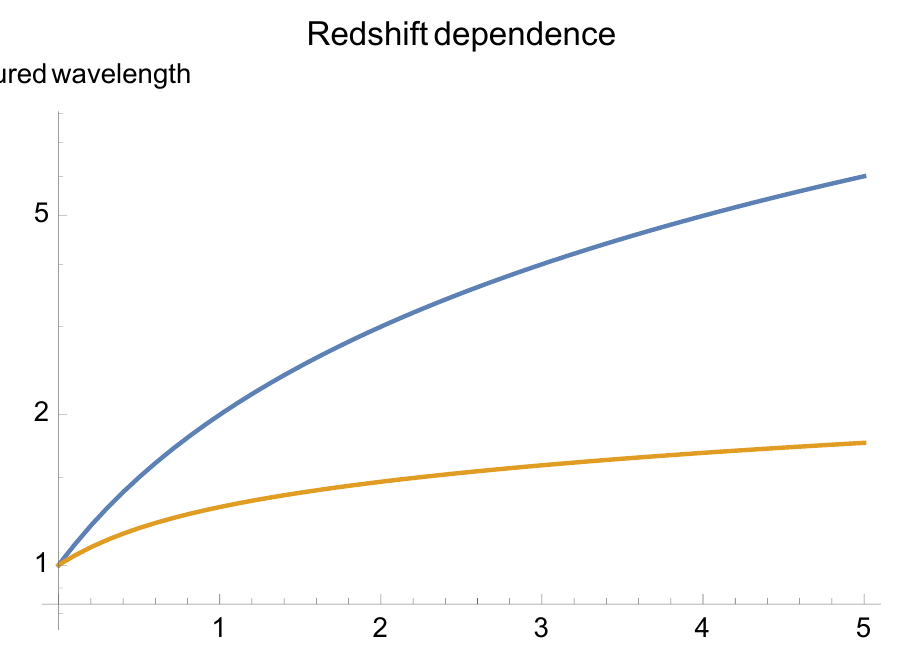
Figure 8. Measured wavelength, normalized to the rest-frame one, as a function of the redshift. The upper curve is for a conventional astrophysical signal, and the lower one is for bouncing black holes. Reproduced from [82], with the permission of AIP